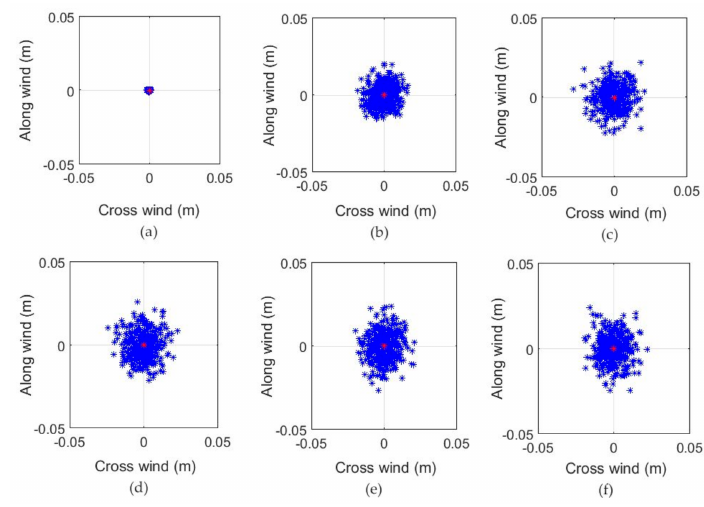
Figure 10. The laser beam centroid calculations shown for laser beam incidence angle of 15 ◦ with various wind speeds. ( a ) still surface ( b ) 2.5 m/s ( c ) 3 m/s ( d ) 3.5 m/s ( e ) 4 m/s ( f ) 5.25 m/s.